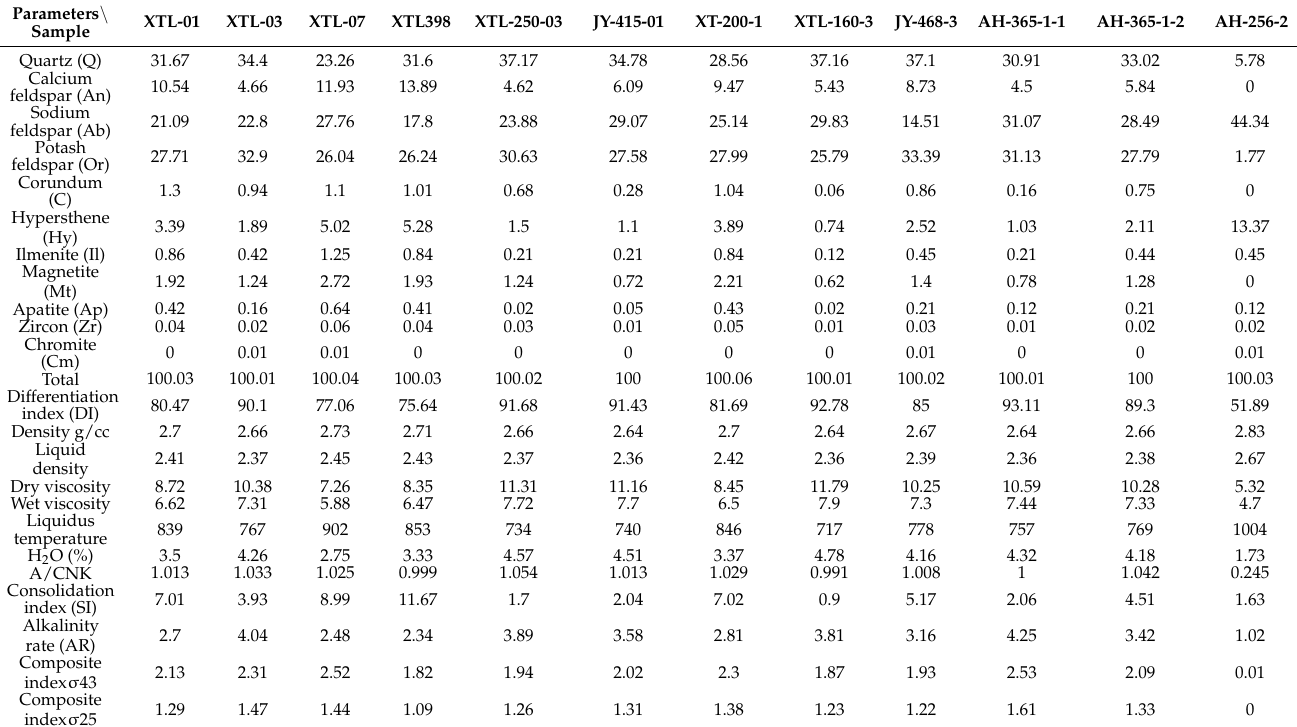
Table 5. CTPW standard minerals in granite in Xintianling ore field, Hunan,